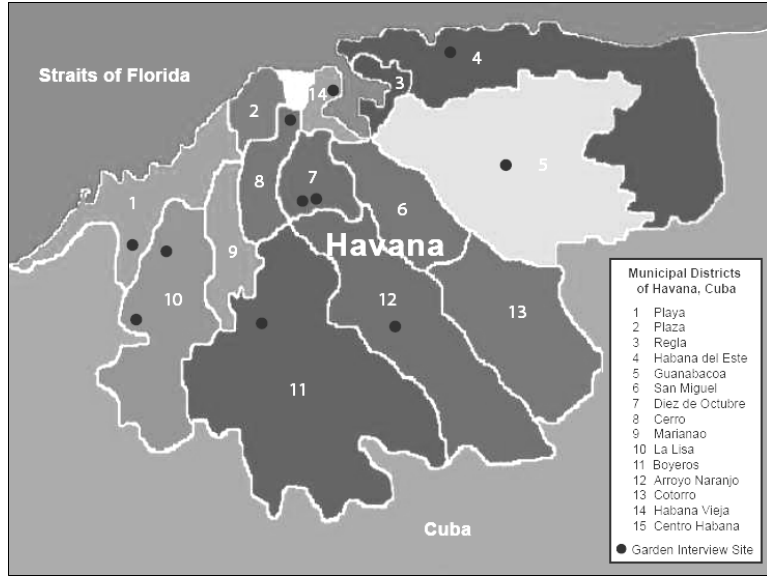
Figure 5. Map of community garden interview sites in